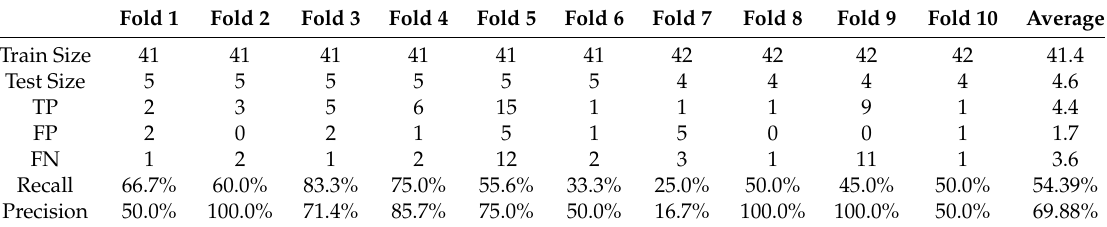
Table A2. The Results of Experiment 2: Filtering the dataset by focusing on only aircraft wings (Dataset 2).